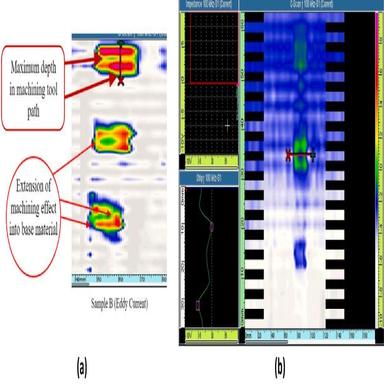
Eddy current array NDT results for (A) Machined notches before SCC, and (B) general and SCC defects after exposing to SCC conditions.